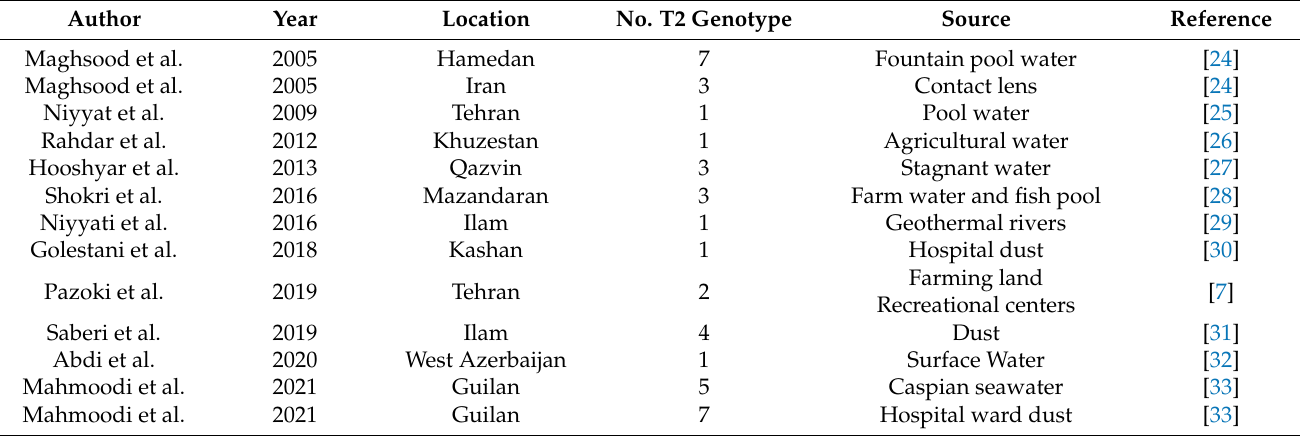
Table 2. Several studies that reported Acanthamoeba genotype T2 from different samples and provinces of